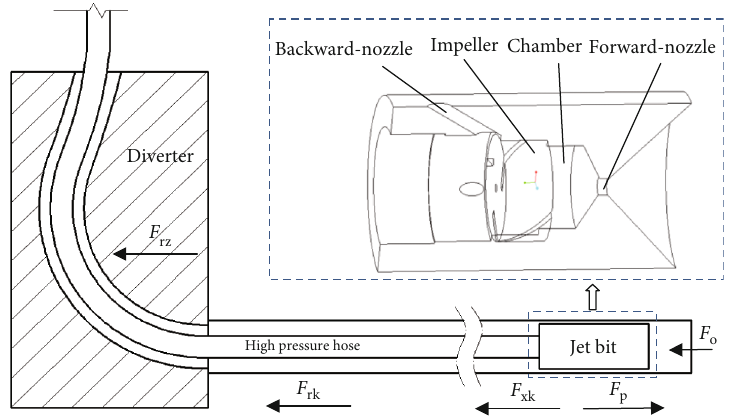
Figure 1: Force model of the RJD